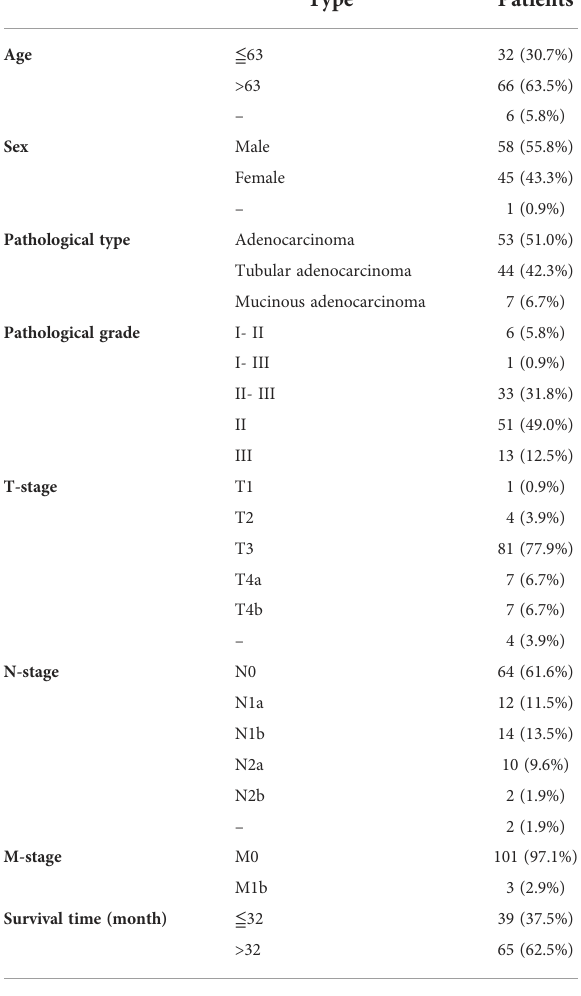
TABLE 1 The characteristics of 104 colorectal cancer patients in our